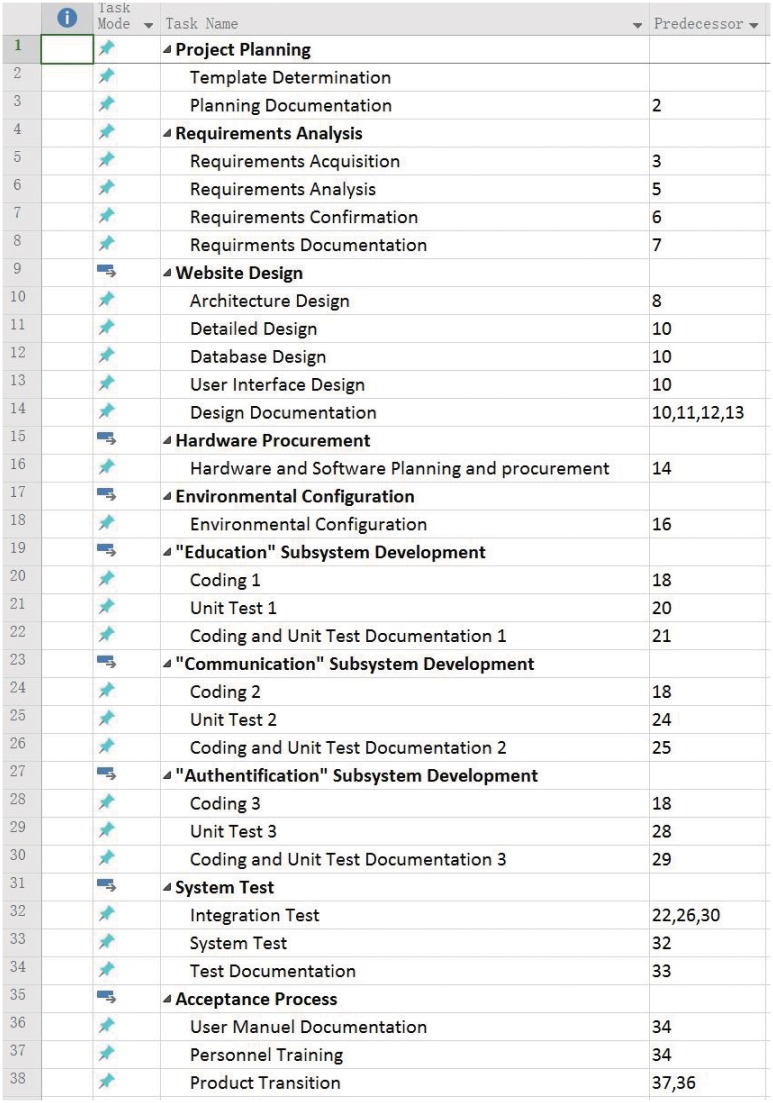
WBS of a Web Site Development Project.